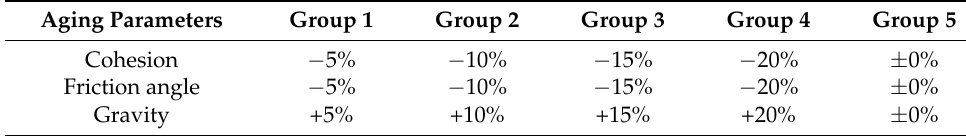
Table 3. Reduction of aging parameters in each